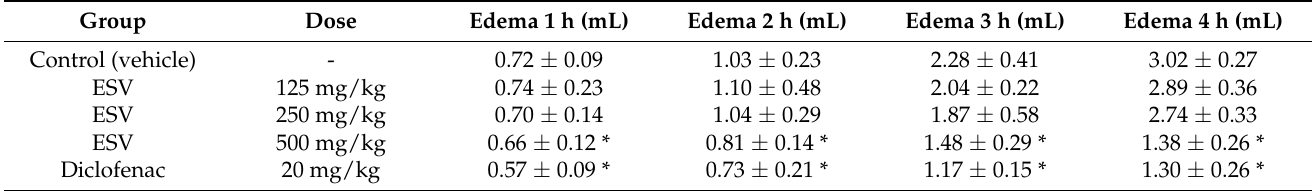
Table 2. Anti-inflammatory effect of the extract from S. virgaurea (ESV) in rat paw edema. Group Dose